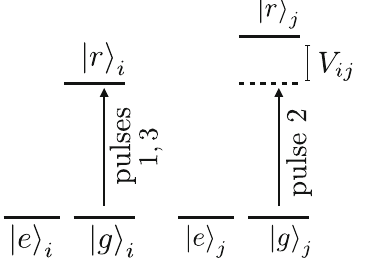
Fig. 15 Entangling gate using the Rydberg blockade and three laser pulses. The first pulse transfers the population in | g i (cid:7) to a Rydberg state | r (cid:7) .Thesecondpulsegives | g (cid:7) aphaseequalto π if | r (cid:7) isunoccupied, i j i and a phase close to π if | r i is occupied. The third pulse transfers the population in | r i (cid:7) to | g i (cid:7) . In this whole sequence, | e i e j (cid:7) is unaffected, and the other three orthogonal states are (approximately) multiplied by − 1, which realizes a controlled-Z